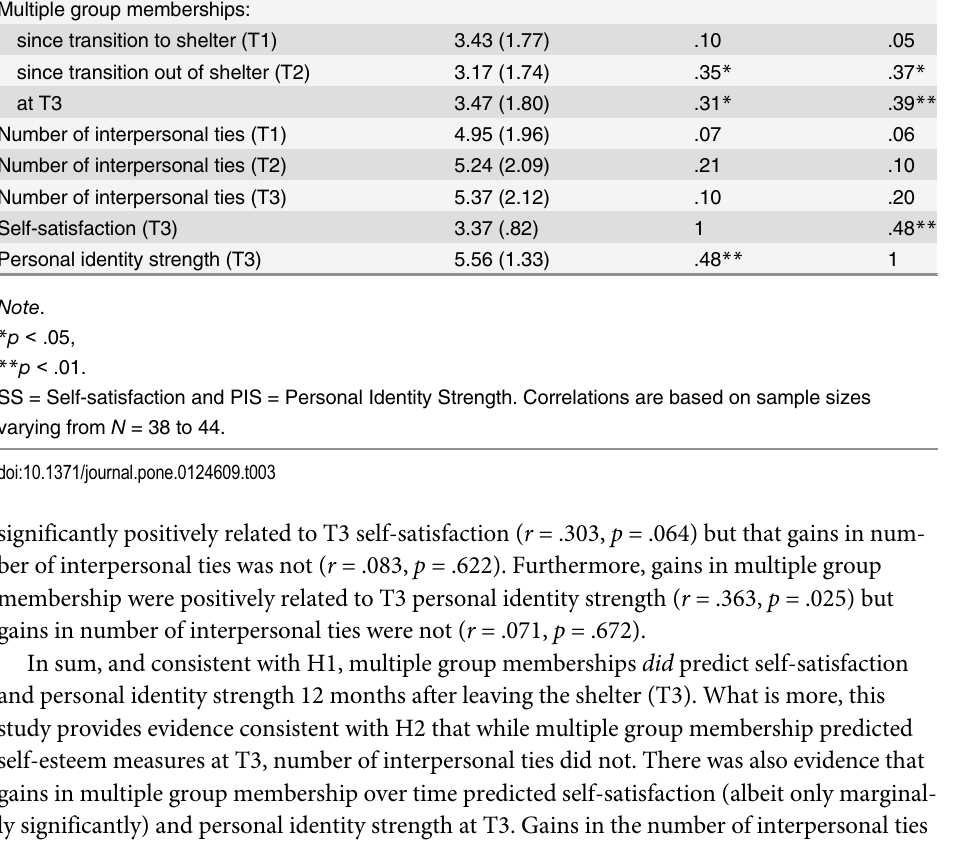
Table 3. Study 1c: Descriptive statistics and bivariate correlations for homeless adults in Australia. M